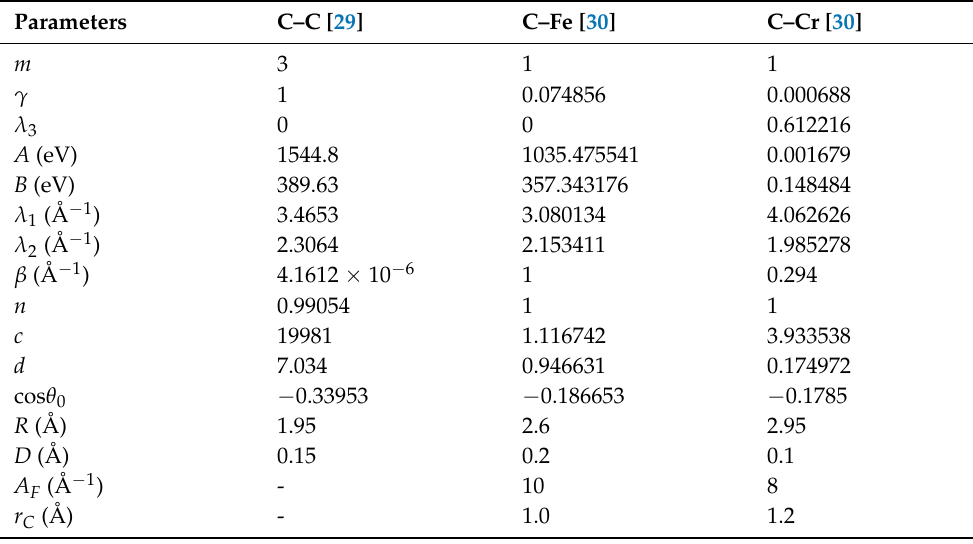
Table 1. Parameters of Tersoff and Tersoff/ZBL potentials used in MD simulations [29,30].